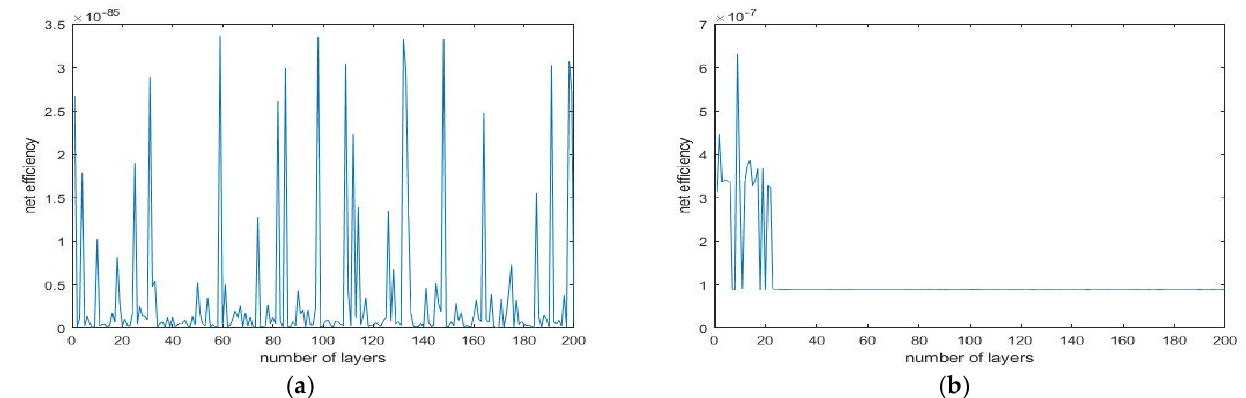
Figure 6. Efficiency of neural networks in approximating various functions with 200 training samples and one output neuron ( m = 200, k = 1). ( a ) y = x 2 ( b ) y = x 1 + x 2 + cos ( x 3 ) + x 4 x 5 , n = 5, r max = 97, r optimum =